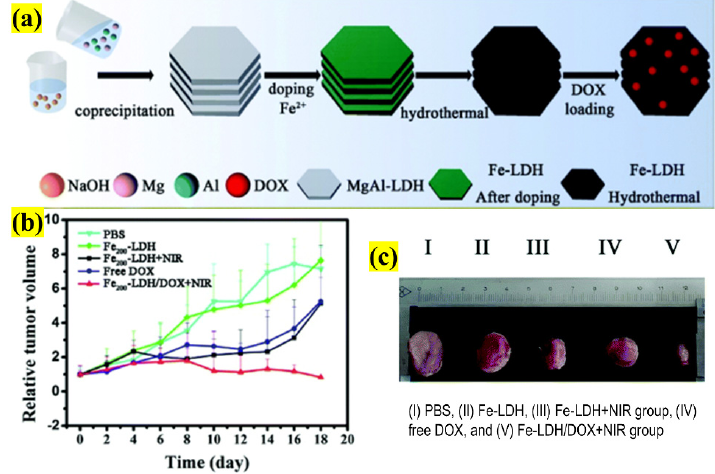
Figure 12. Schematic illustration representing ( a ) the design and preparation of Fe-doped LDH and functionalized with DOX as a nanotheranostic platform for combined therapy, ( b ) the tumor volume, ( c ) photographs of tumor tissue removed from various groups of mice after treatment in the presence or absence of NIR irradiation (adapted with permission from Reference [74], Biomaterials Science, published by The Royal Society of Chemistry, 2021).